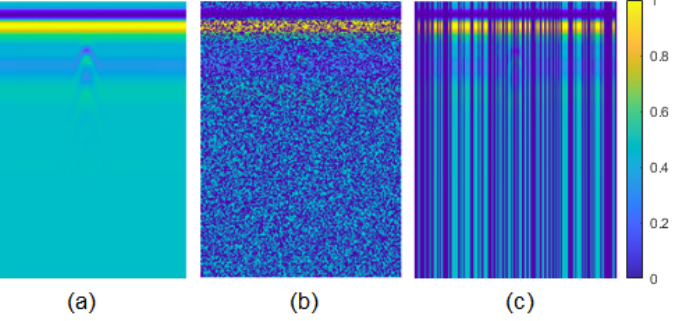
Figure 1. ( a ) Raw GPR image, ( b ) sample GPR image with pixel-wise missing entries, ( c ) sample GPR image with column-wise missing entries.